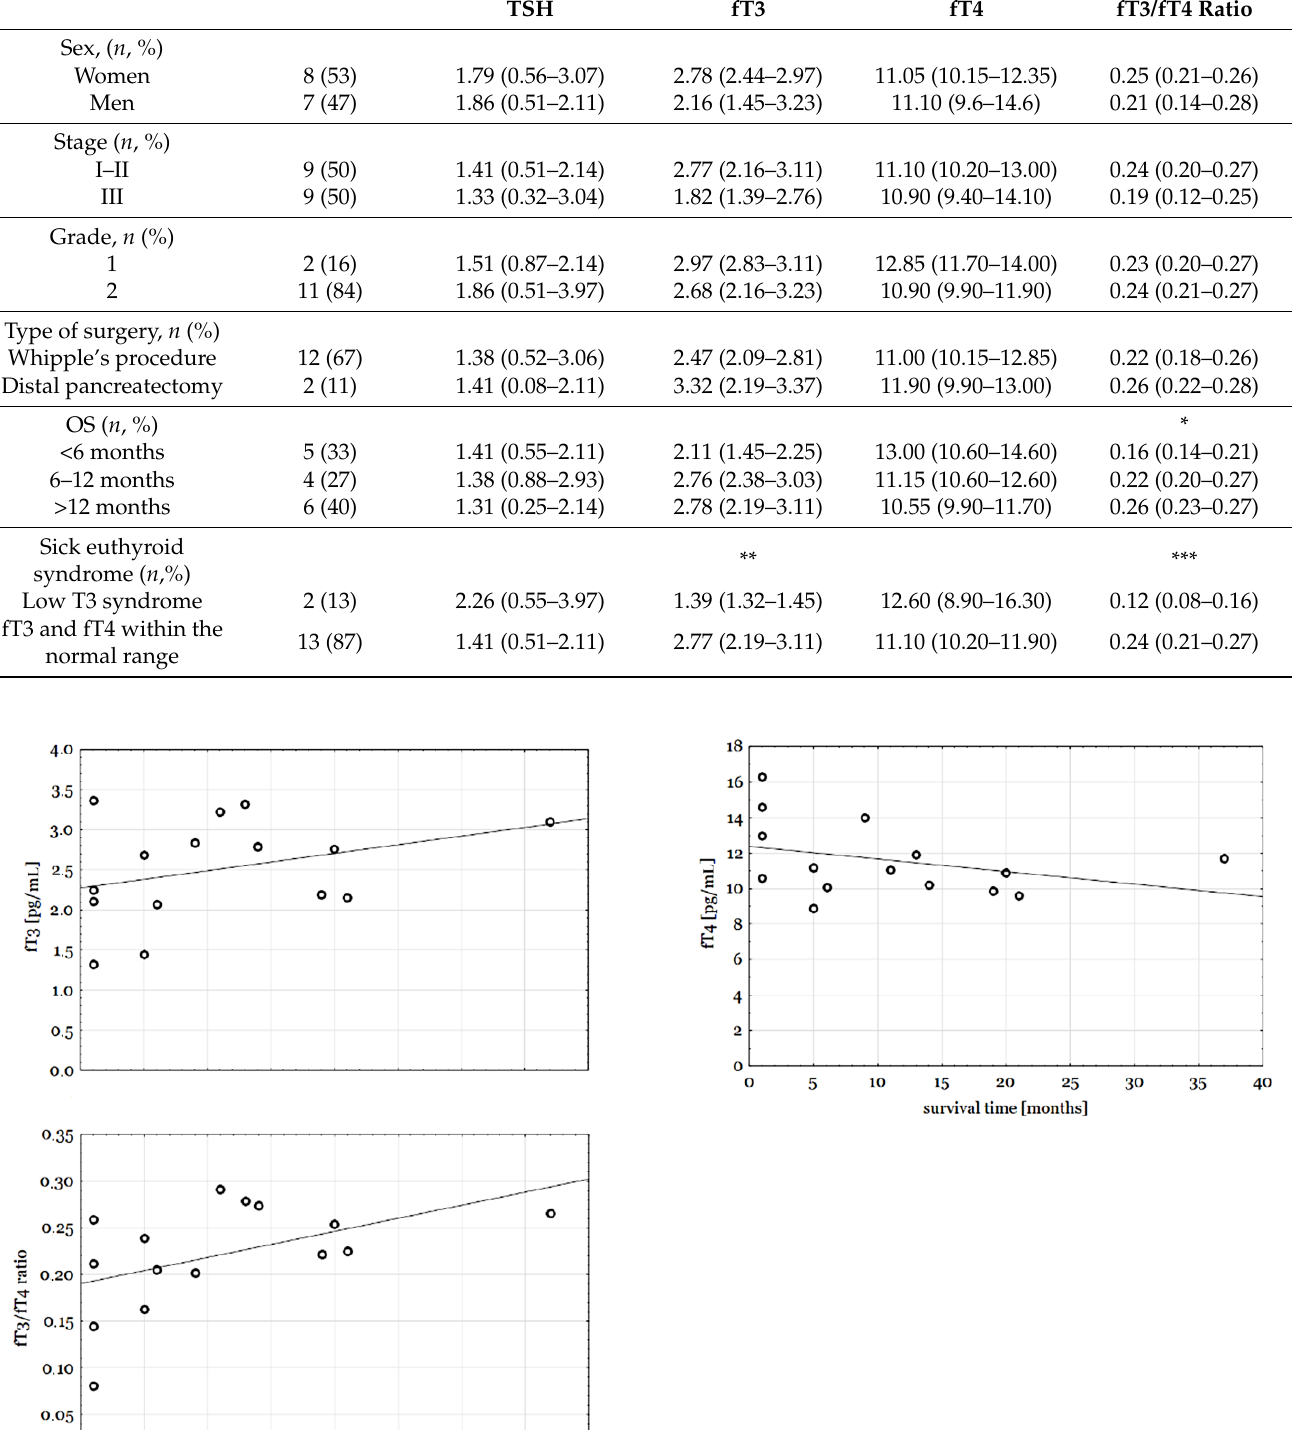
Figure 2. ROC curves for 6-months and 1-year survival, according to fT3/fT4 ratio status.